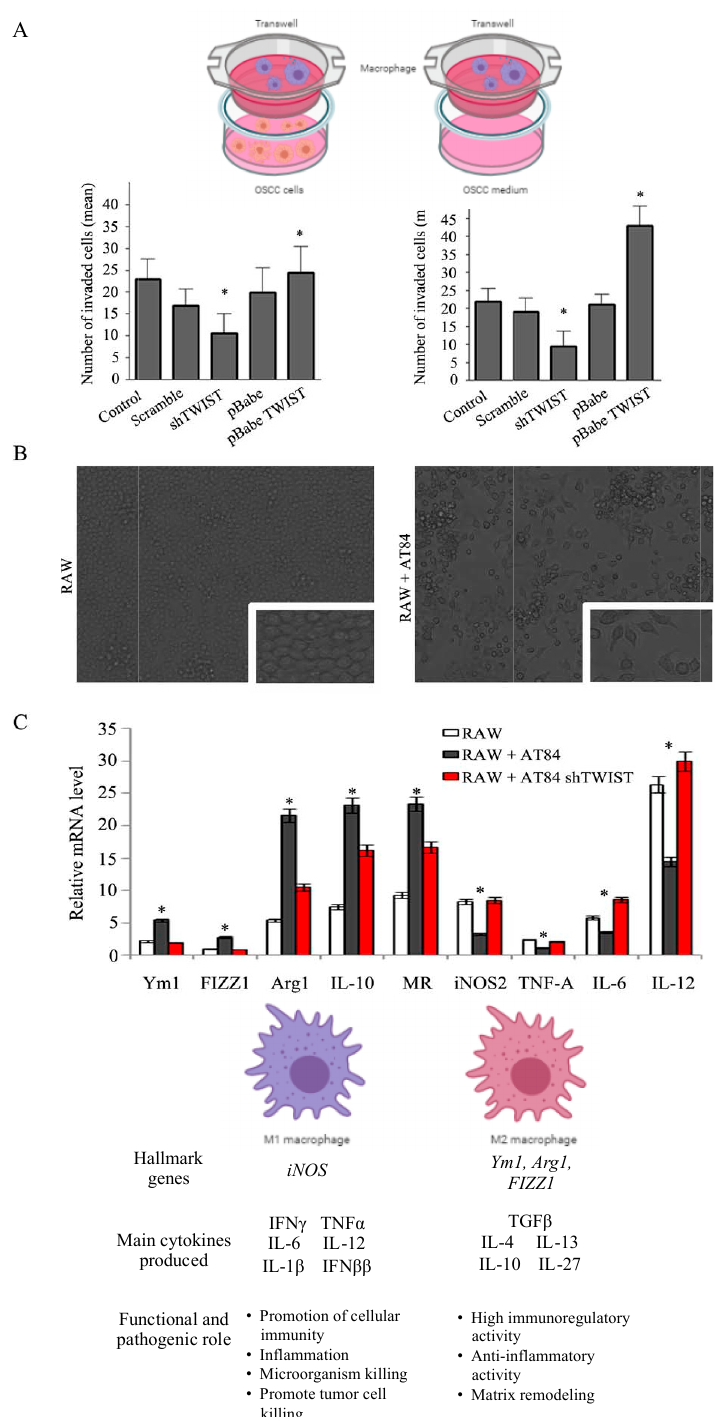
Figure 4. TWIST1 can regulate macrophage chemotaxis and polarization in metastatic oral cancer. ( A ) TWIST1 inhibition leads to decreased macrophage migration. Using a model of migration